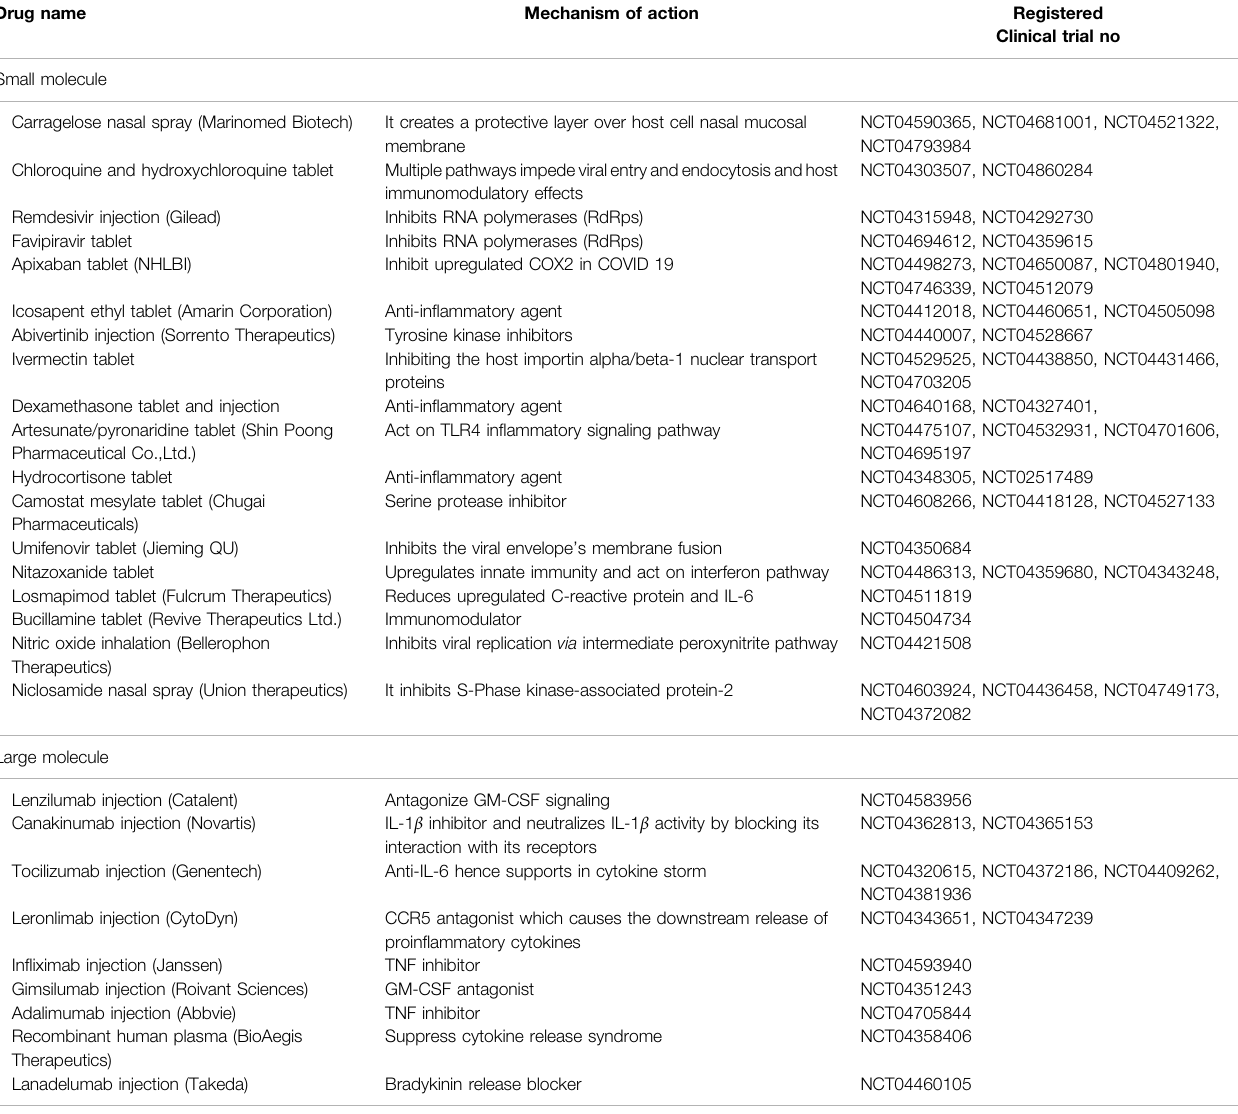
TABLE 1 | Drugs repurposed for